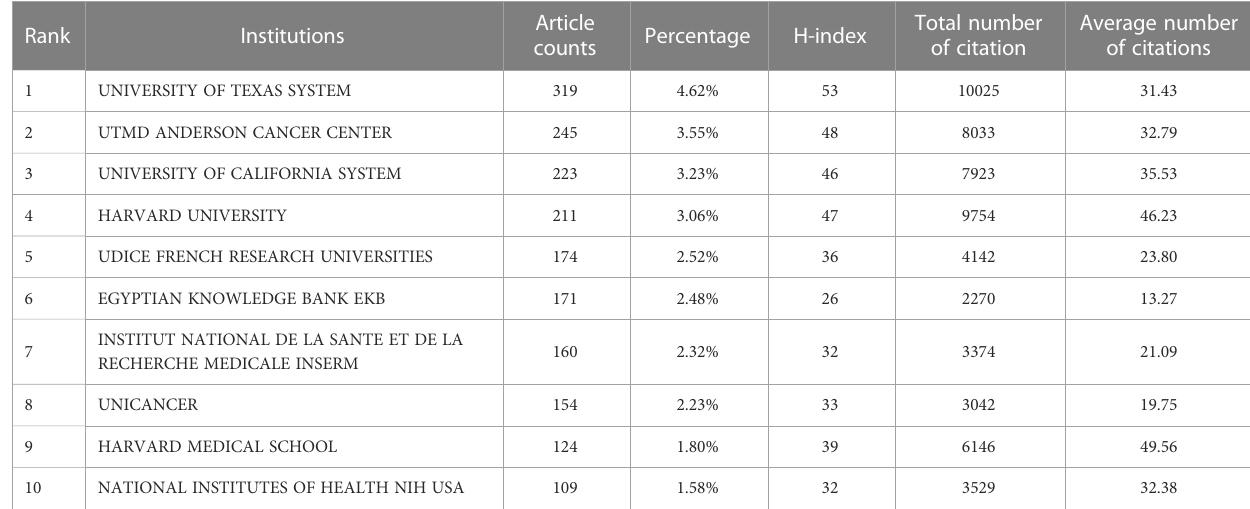
TABLE 2 The top 10 institutions contributing to publications about in fl ammation in breast cancer.